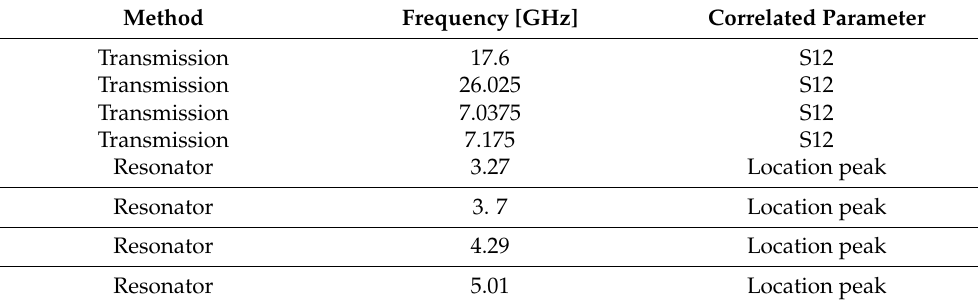
Table 7. Summary of the correlation between nitrogen concentration and electromagnetic